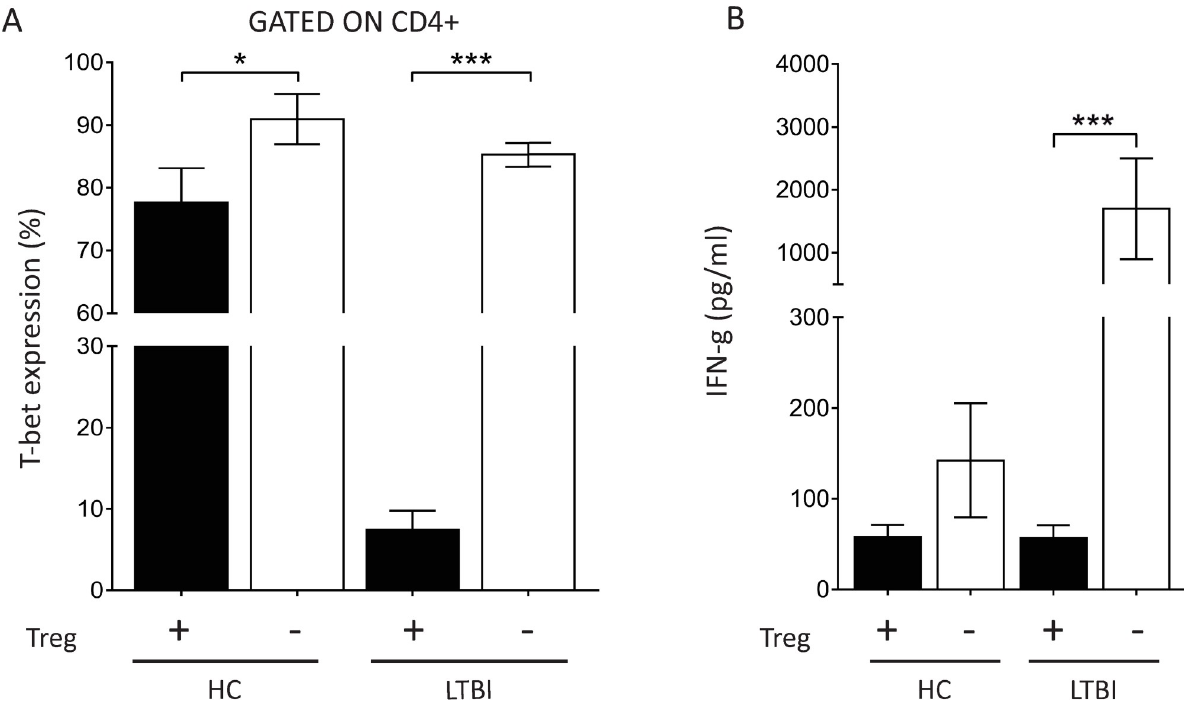
Fig 5. Depletion of CD4 + CD25 + FoxP3 + T cells restored the TH1 profile in LTBI individuals. PBMC samples from healthy control subjects (HC, n = 5) and latent infected individuals (LTBI, n = 5) were depleted of CD4 + CD25 + cells. Whole PBMC and Treg-depleted PBMC samples were infected with Mtb H37Rv strain for 72 hours in vitro . ( A) Intracellular expression of T-bet analyzed on CD4-gated population by flow cytometry; (B) Soluble levels of IFN-y in PBMC culture supernatants determined by ELISA. Statistical relevance ( � = p < 0.05; ��� = p < 0,0001) was assessed using ANOVA